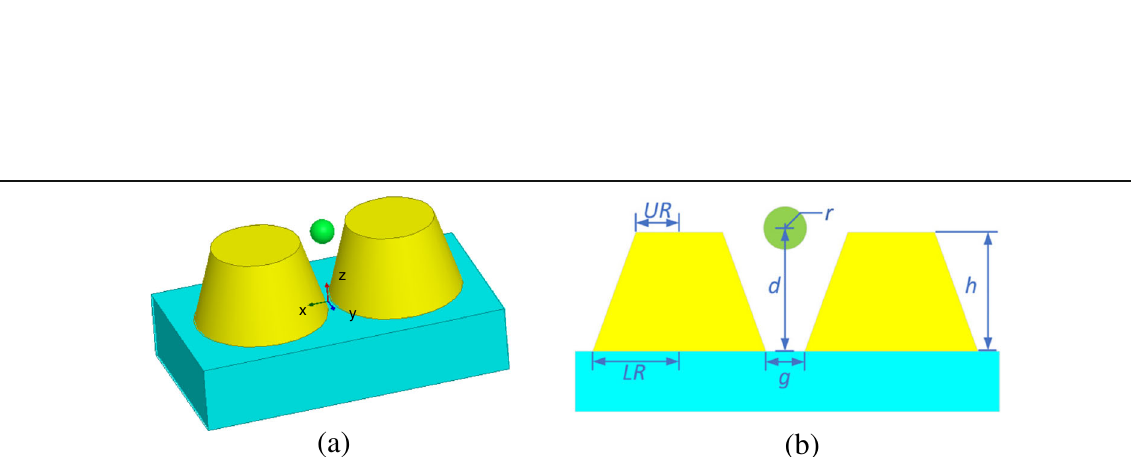
Fig. 9 Configuration of an optical trapping system of a gold truncated cone dimer based on a dielectric substrate in water. a 3D view. b Front view and dimensions, where UR = 20 nm, LR = 30 nm, h = 35 nm, and g = 2